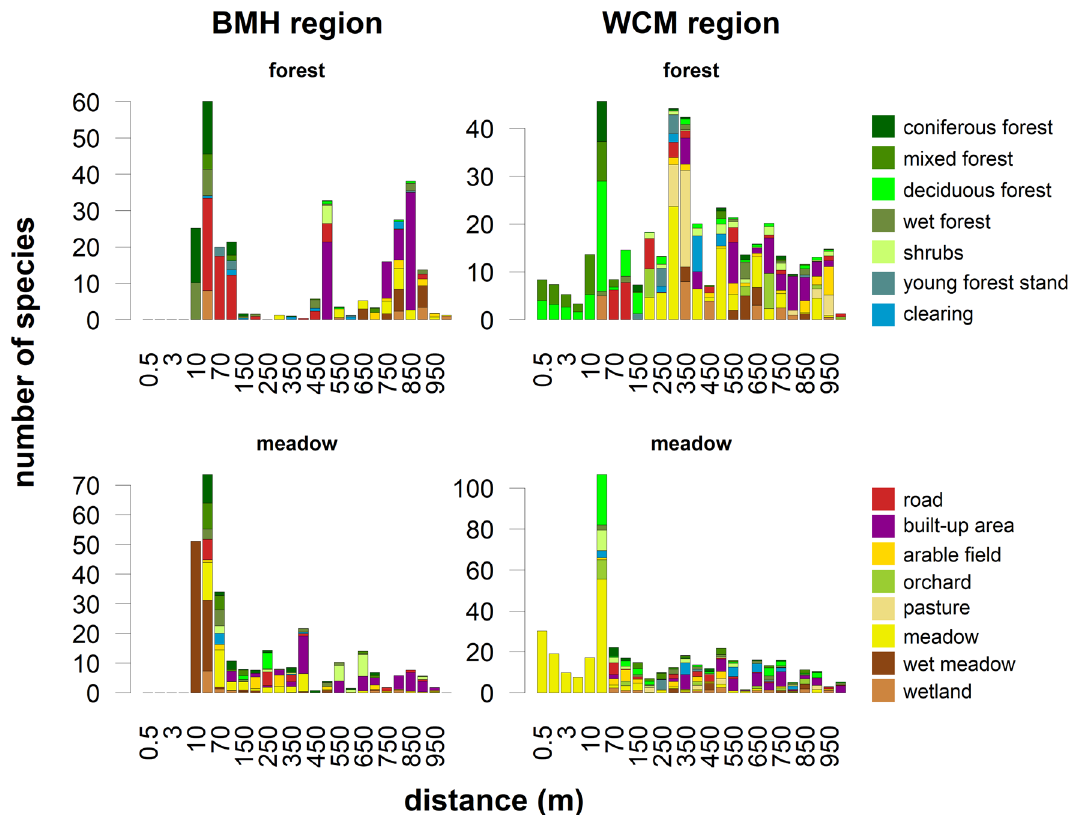
Figure 5. Numbers of new species recorded with increasing radius in different study regions and habitats. Colours code habitats, where the plants species were